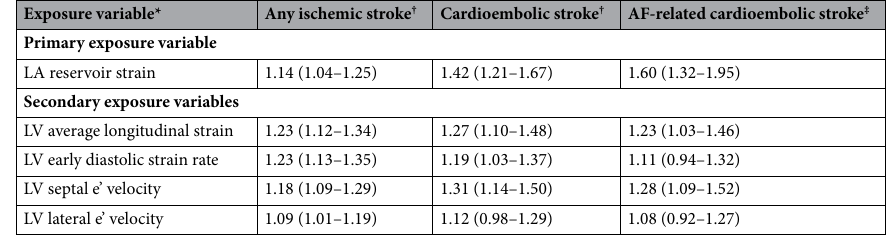
Table 4. Associations between myocardial mechanics and incident ischemic stroke subtypes in the cardiovascular health study. LA, left atrial; LV, left ventricular. *Reported results represent the hazard ratio (95% confidence interval) for ischemic stroke per each standard deviation absolute decrease in strain and decrease in strain rate and e’ velocity. Lower absolute values represent worse strain. † Models were adjusted for age, race, sex, study site, speckle-tracking analyst, chamber-specific echocardiogram image quality, education, body mass index, coronary heart disease, heart failure, diabetes, systolic blood pressure, anti-hypertension medication, high-density lipoprotein level, low-density lipoprotein level, log-transformed triglyceride level, smoking status, LV ejection fraction, and atrial fibrillation as a time-varying covariate. ‡ Models were adjusted as in footnote b except for atrial fibrillation as a time-varying